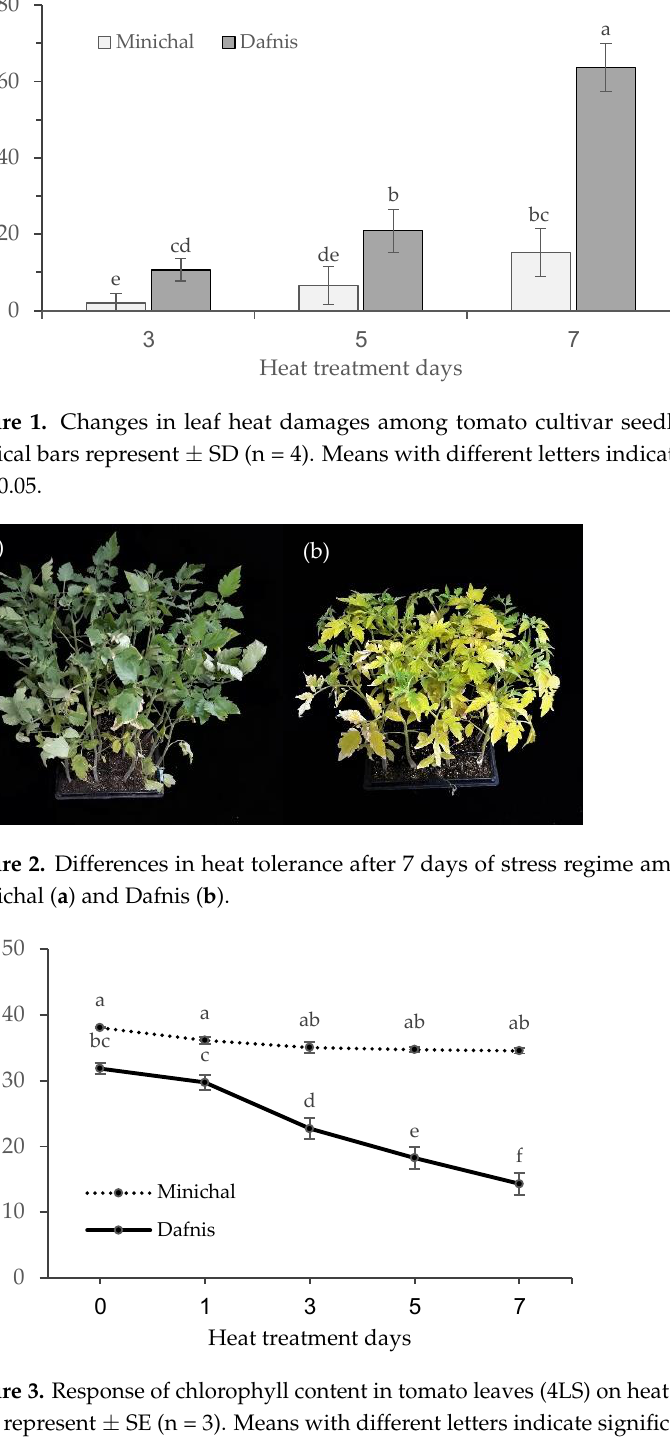
Figure 3. Response of chlorophyll content in tomato leaves (4LS) on heat treatment periods. Vertical bars represent ± SE (n = 3). Means with different letters indicate significant differences at p ≤ 0.05.